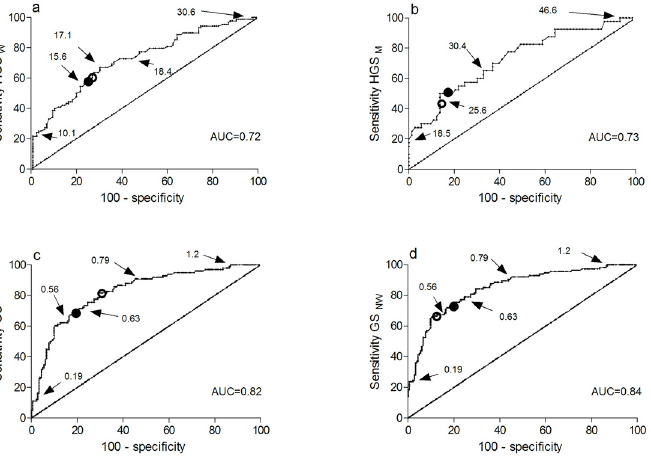
Fig 2. Receiver-operator characteristic (ROC) curves showing sensitivity and 100-specificity for prediction of mobility status 30 days after discharge, according to varying cut-offs for gait speed and handgrip strength. To illustrate the range of data and to show how the different cut-offs influence the sensitivity and specificity in the present study, selected absolute values are shown with arrows. Preselected cut-offs are marked with black circles, and cut-off based on Youden Index are shown with open circles. HGS W : handgrip strength (kg), women, HGS M : handgrip strength (kg), men, GS: gait speed (m/s), GS NW: Including patients without walking ability at admission (m/s), AUC: area under the